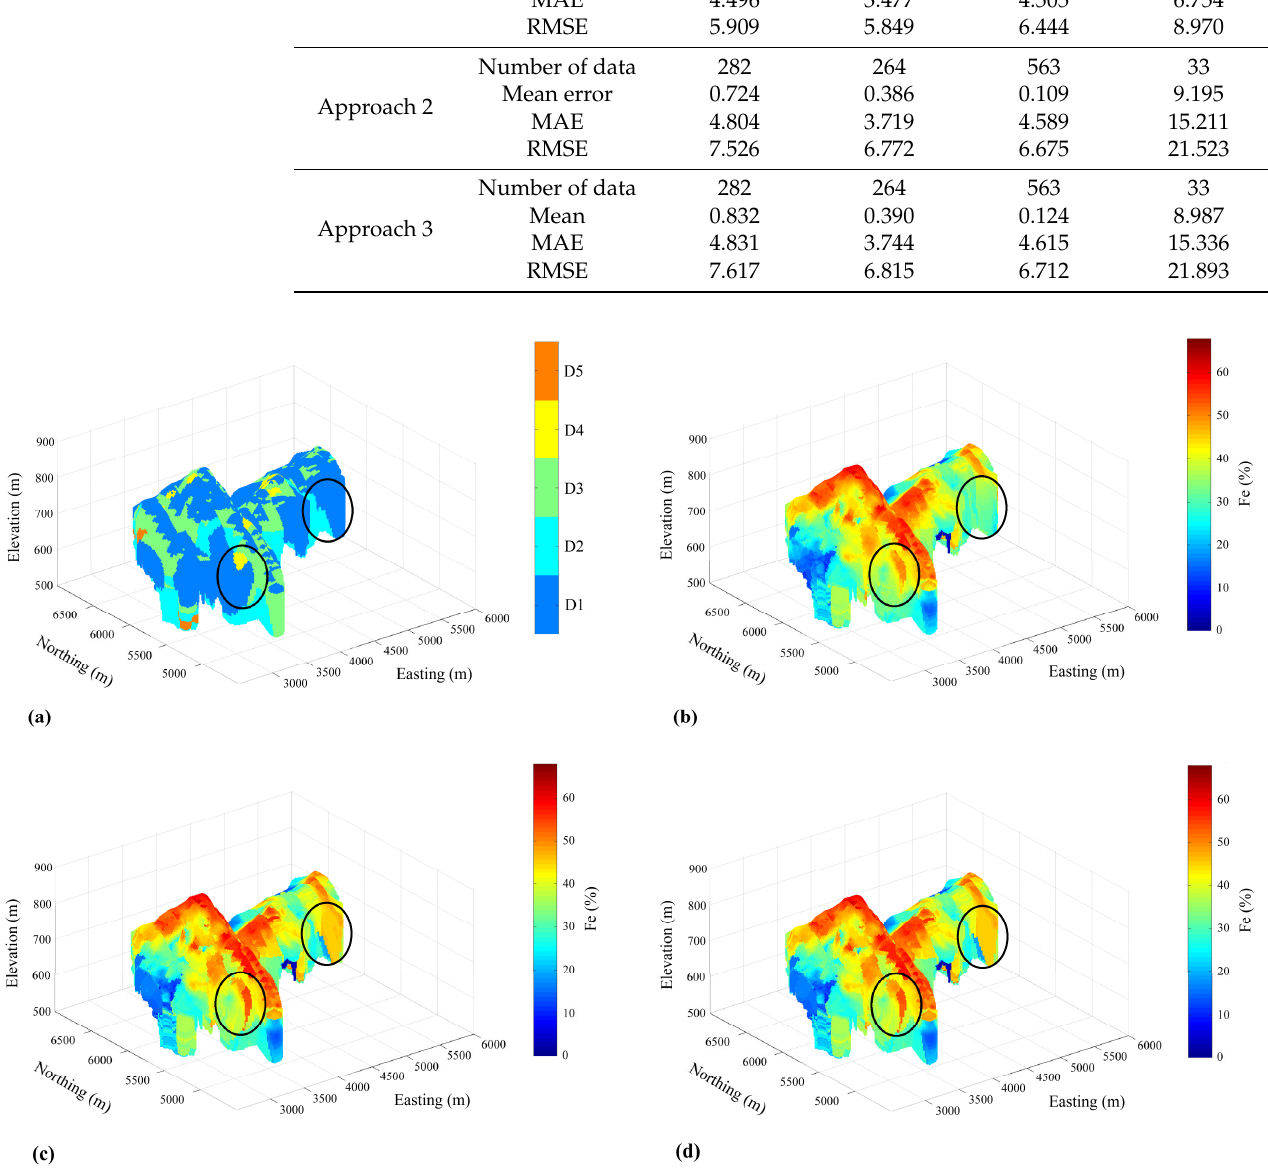
Figure 7. ( a ) Interpreted geological model showing the domain layouts; ( b ) estimated iron grade as per approach 1; ( c ) estimated iron grade as per approach 2; ( d ) estimated iron grade as per